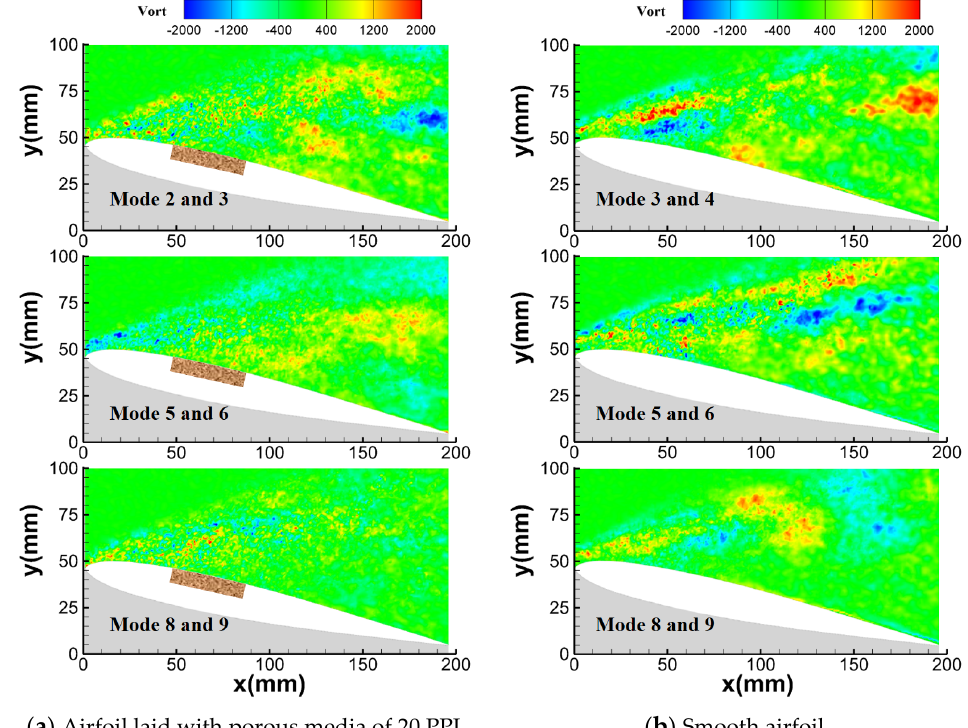
Figure 14. Conjugate modes.